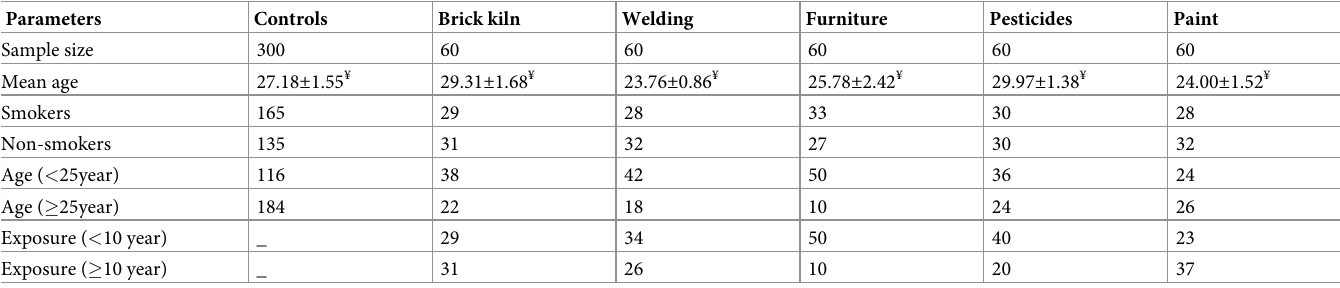
Table 1. Demographic data of control and exposed group of furniture, paint, welding, pesticide and brick kiln industry.